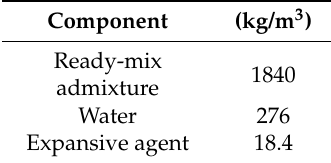
Table 2. Matrix M2